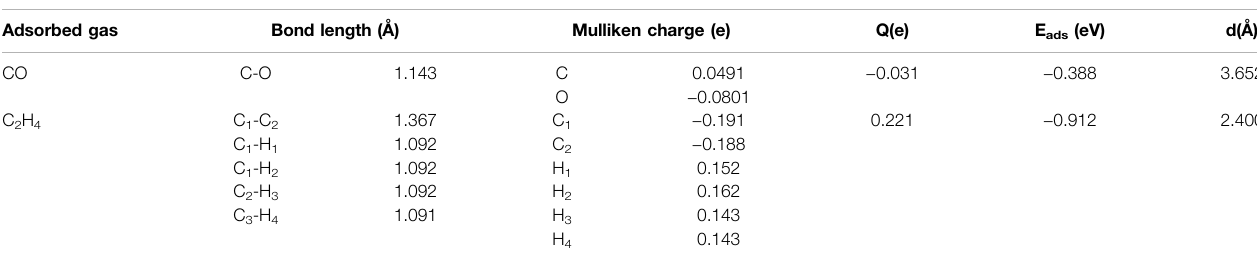
TABLE2 | Adsorption characteristic parameters of CO and C 2 H 4 on the doped monolayer. Adsorbed